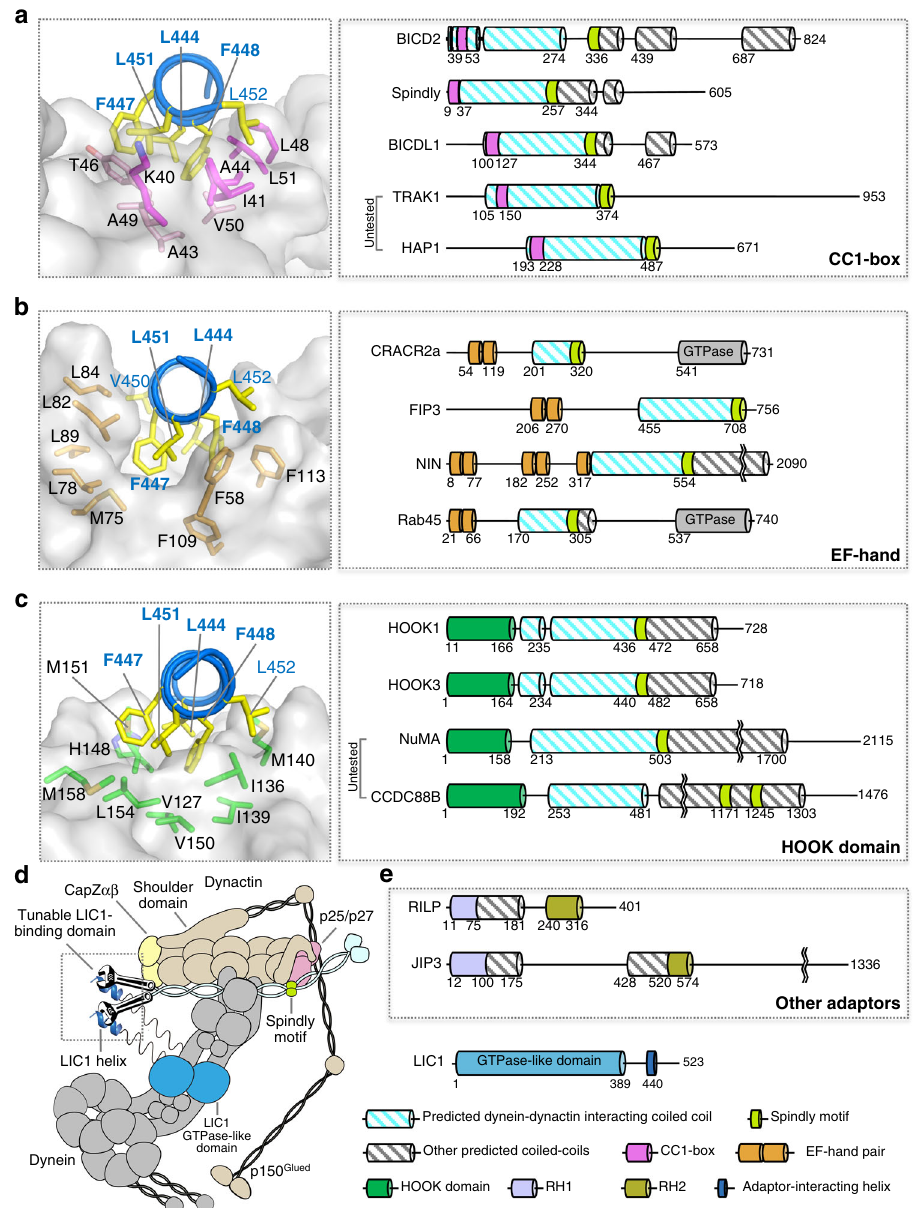
Fig. 6 Classi fi cation of dynein – dynactin adaptors into three subfamilies with different LIC1 interactions. a – c Residues L444, L451, F447, and F448 (bold) on the hydrophobic side of the LIC1 helix insert into a hydrophobic cleft in all the adaptors, which use different folds and different protein – protein contacts to binds this helix (see also Supplementary Fig. 6) : CC1-box (magenta), EF-hand pair (orange), and HOOK domain (dark green). Based on this interaction, the adaptors fall into three subfamilies, each containing several members with different domain architectures (for a complete list see Supplemental Table 1). C-terminal to the LIC1-binding site, all the adaptors present a coiled-coil segment (striped cyan) that binds the dynactin actin-like fi lament and provides part of the binding interface for the dynein tails 5,9,12 . C-terminal to the dynactin-binding coiled-coil, the adaptors have the Spindly motif (light green) that interacts with subunits p25/p27 at the pointed end of the dynactin complex (see also Supplementary Fig. 5). d Schematic representation of the LIC1 – adaptor interaction within the context of dynein – dynactin – adaptor complexes. A prototypical adaptor is depicted (cyan), showing the variable (tunable) interaction with the LIC1 helix near CapZ αβ at the barbed end of the dynactin fi lament, the coiled-coil segment that binds dynein – dynactin, and the Spindly motif. C-terminal to the Spindly motif the adaptors differ the most. This variable region is directly or indirectly responsible for the recruitment of speci fi c cargoes. e Members of the RILP and JIP family share some features with the dynein – dynactin adaptors, including the ability to bind LIC1, but are unlikely to activate processive motility 1